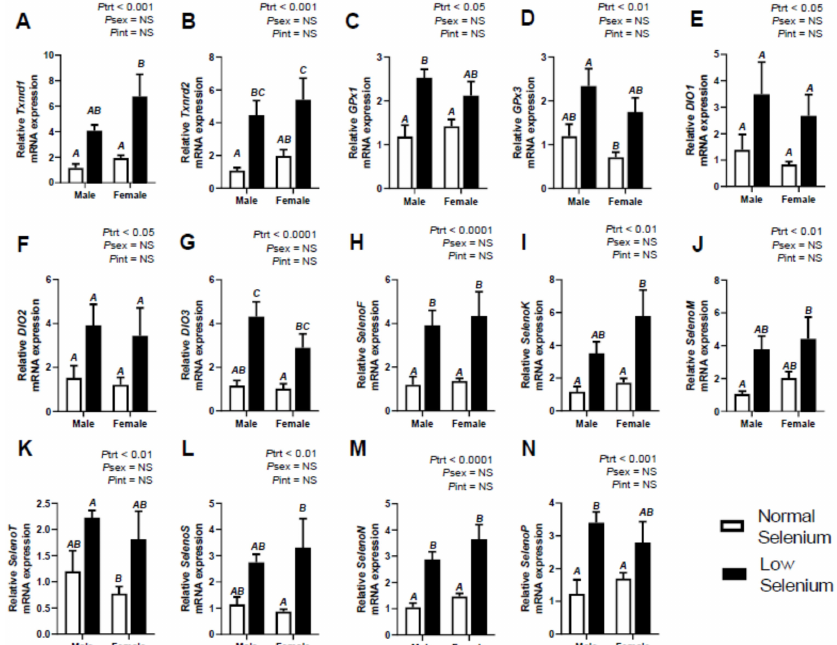
Figure 2. E ff ects of selenium deficiency on selenoprotein expression in fetal kidneys at E18.5. Expression in male and female fetal kidneys, at E18.5, of; ( A ) thioredoxin reductase 1, ( B ) thioredoxin reductase 2, ( C ) glutathione peroxidase 1, ( D ) glutathione peroxidase 3, ( E ) deiodinase 1, ( F ) deiodinase 2, ( G ) deiodinase 3, ( H ) selenoprotein F, ( I ) selenoprotein K, ( J ) selenoprotein M, ( K ) selenoprotein T, ( L ) selenoprotein S, ( M ) selenoprotein N and ( N ) selenoprotein P. Data are mean ± SEM and analysed by two-way ANOVA with treatment ( P trt ) and sex ( P sex ) as major factors. P int represents the interaction between treatment and sex. Significance was determined as p < 0.05. If a major e ff ect of treatments, sex or an interaction between treatment and sex was identified, then a Sidak posthoc test was performed. Significant di ff erences between groups as detected by posthoc analysis are denoted by di ff erent letters where “A” is di ff erent from “B” which is di ff erent from “C”. “A” is not di ff erent from “A” or “AB”, “B” is not di ff erent from “B”, “AB” or “BC”. The groups are Normal male, n = 6 (6 animals from 6 separate litters); Low male, n = 6 (from 6 separate litters); Normal female, n = 6 (from 6 separate litters); Low female, n = 6 (from 6 separate